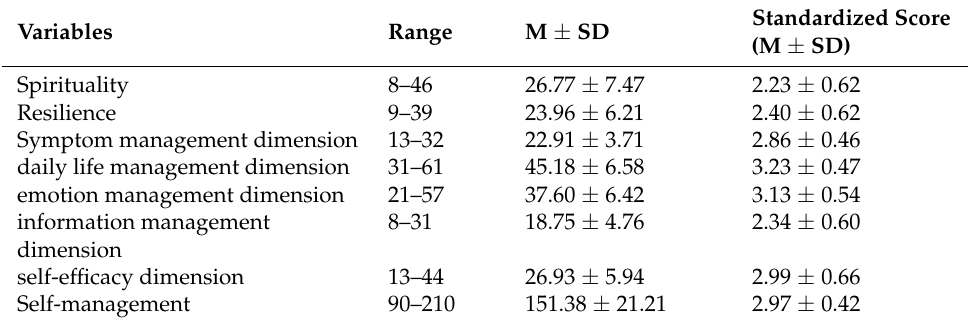
Table 2. Descriptive statistics of target variables.